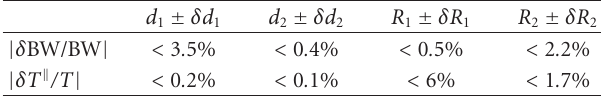
Table 1: Sensitivity analysis of the structure shown in Figure